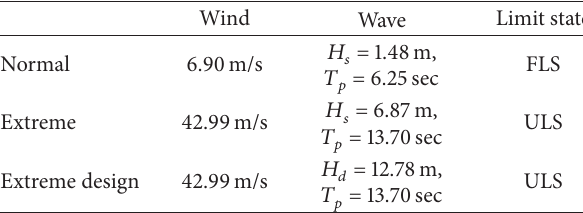
Table 5: Environmental